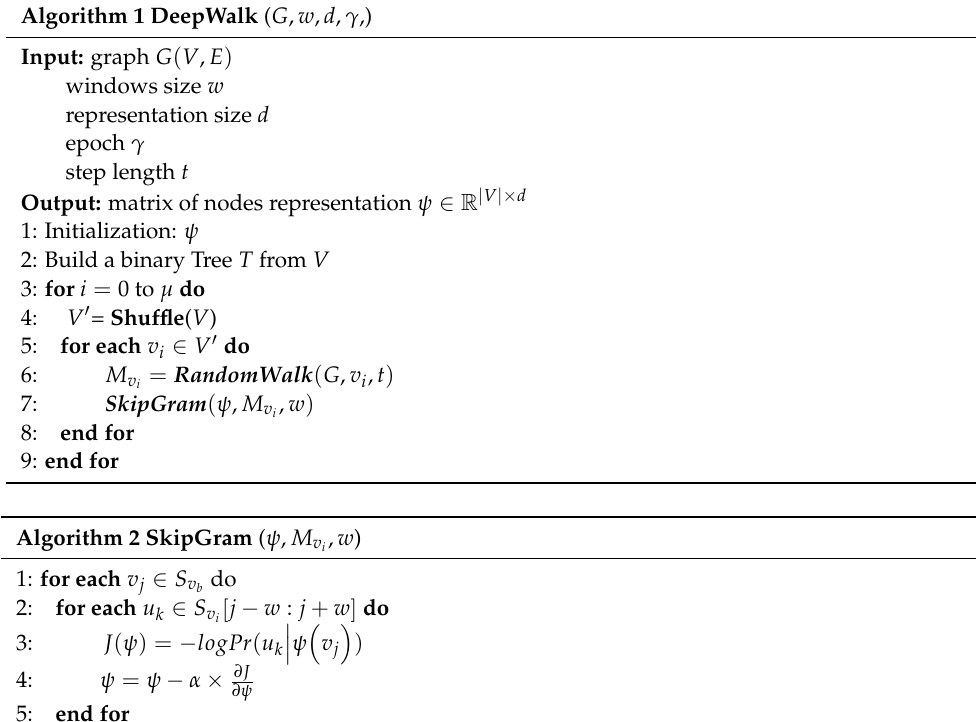
Algorithm 1 DeepWalk ( G , w , d , γ ,)